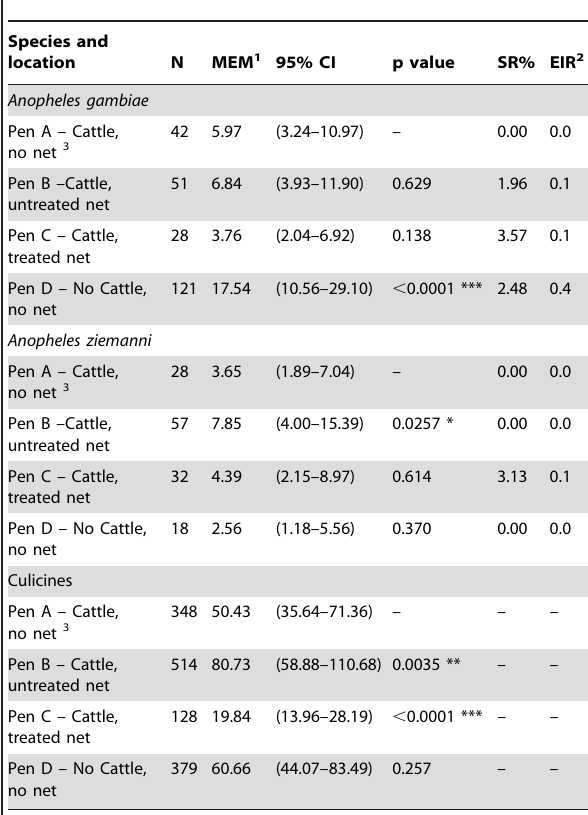
Table 1. Total number of mosquitoes, model estimated means (MEM) and 95% confidence intervals (95%CI) of